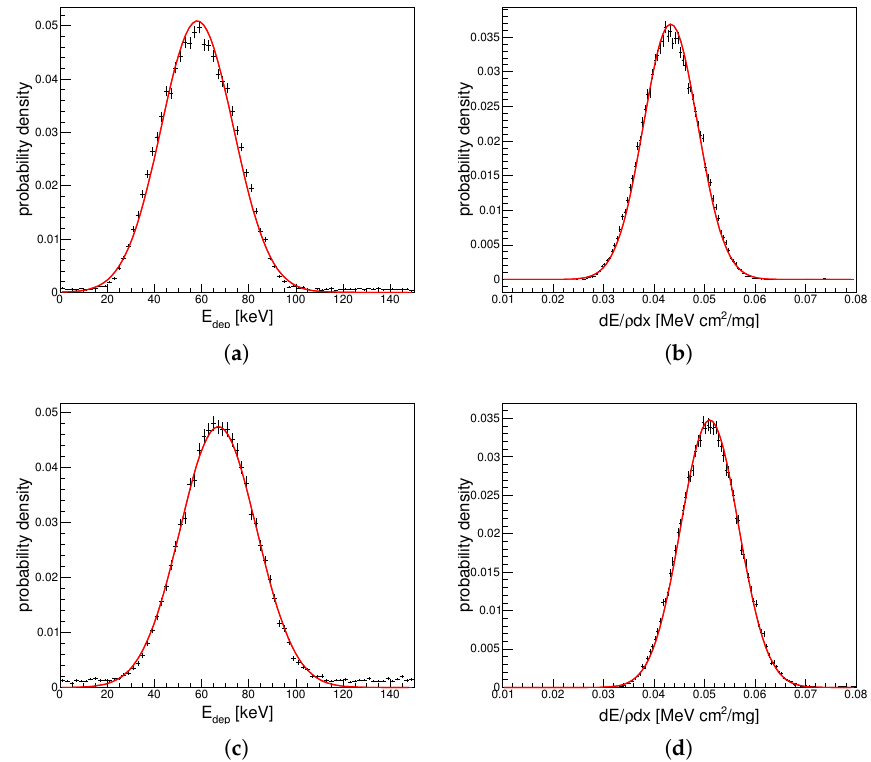
Figure 5. ( a ) distribution of energy deposited per individual proton track ( E dep ) in the ionization chamber and ( b ) track-averaged spectrum of d E / ρ d x in the active layer of the film for the 10.7MeV proton beam; ( c , d ) are the same to (a,b) for the 8.8MeV proton beam. The red curves are the Gaussian fits of the simulation results (black markers). Mean values and uncertainties of the Gaussian fits are reported in Table 2. The referred proton beams were obtained after degradation in air and tungsten foils (see main text for